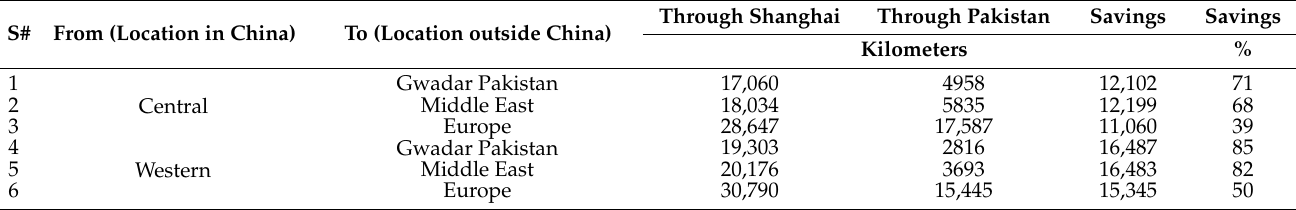
Table 1. Trade distance difference (Shanghai vs.